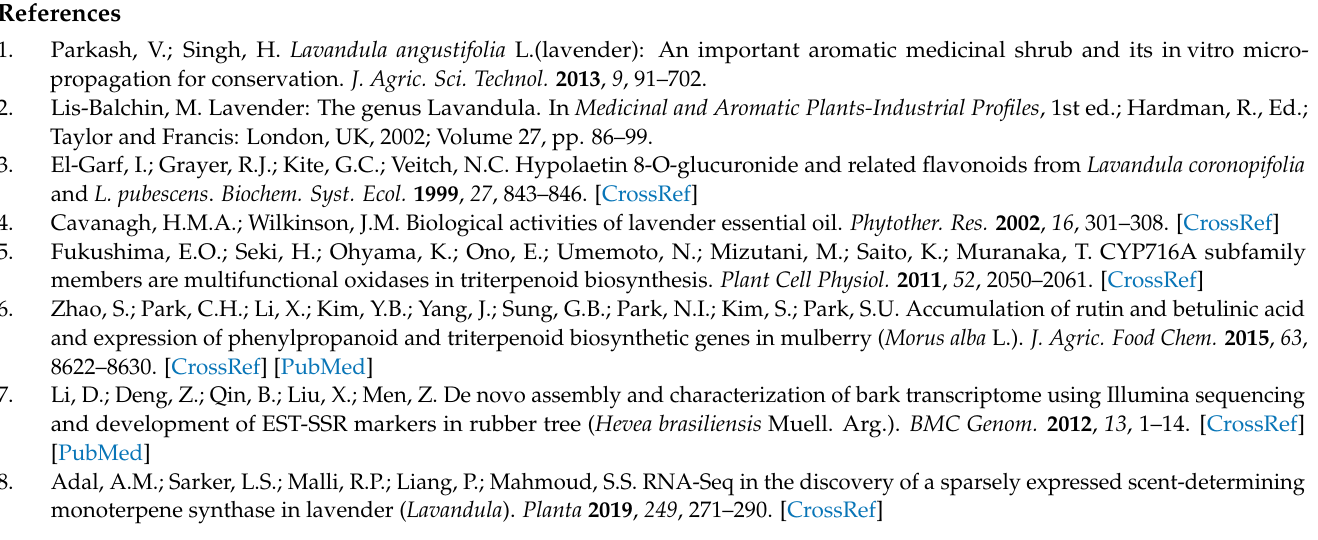
Figure S3: GO annotation of the Lavandula pubescens unigenes, Figure S4: Heatmap representing differences in relative metabolite concentrations of roots, leaves, and stems of Lavandula pubescens . Increasing and decreasing the contents of metabolites are shown by red and blue color, respectively, Table S1: Summary of unigenes in the Lavandula pubescens , Table S2: Summary of the annotation of Lavandula pubescens unigenes, Table S3: Comparison of terpene biosynthetic genes of Lavandula pubescens with orthologous genes and proteins showing the highest identity, Table S4: Primers designed based on terpene biosynthetic gene